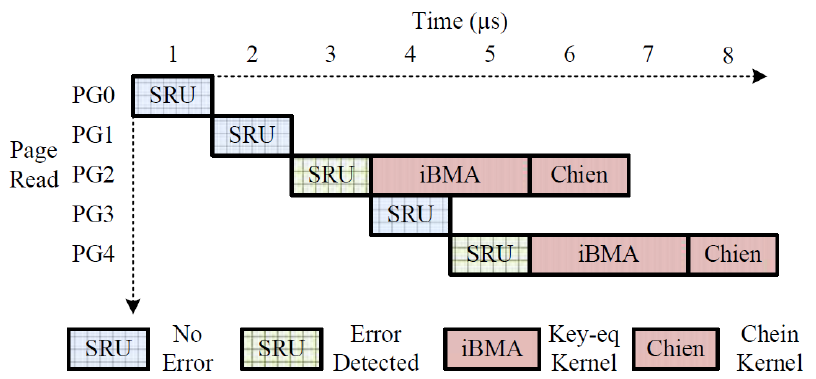
Figure 5. Decoder execution sequence. PG,